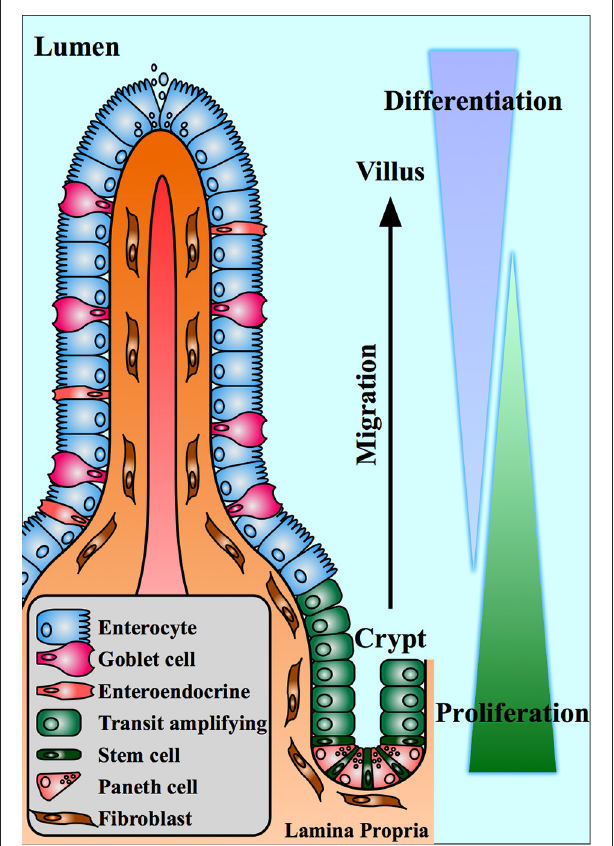
FIGURE 1 | The intestinal crypt-villus axis. The small intestinal epithelium is organized into villus projections into the gut lumen and crypt invaginations into the lamina propria. Stem cells at the base of the crypt produce proliferative daughter cells that give rise to differentiated cells of the villus. Epithelial cells migrate from the proliferating compartment toward the tip of the villus where they undergo